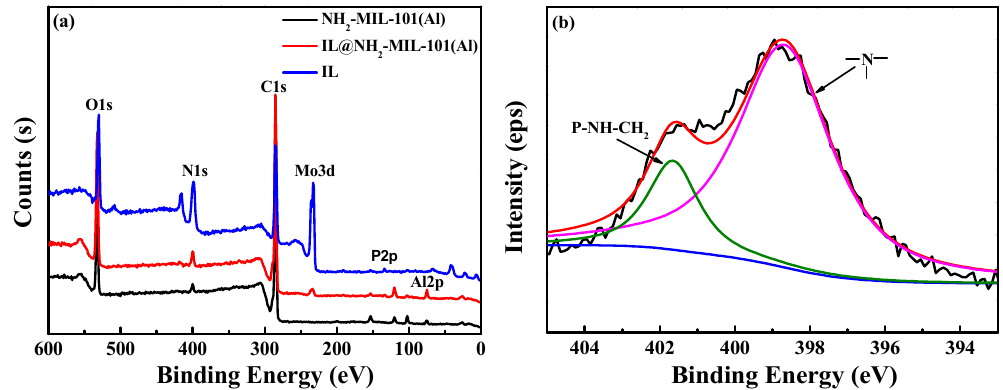
Figure 4. The XPS spectra ( a ) of IL, NH 2 -MIL-101(Al) and IL@NH 2 -MIL-101(Al) and the high-resolution XPS spectra of N 1s regions ( b ) of IL.